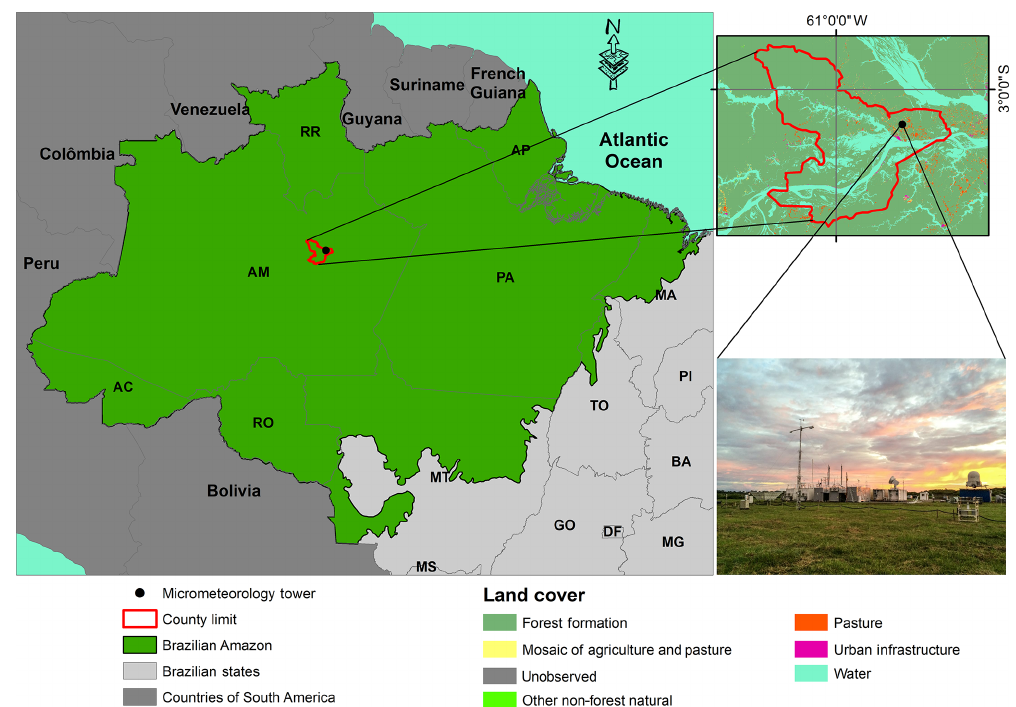
Figure 1. Location of the atmospheric measurement experiments in Manacapuru, Amazonas,